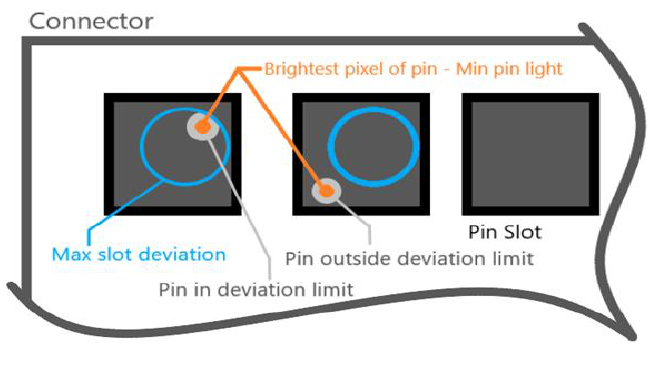
Figure 24. Some pins parameters.